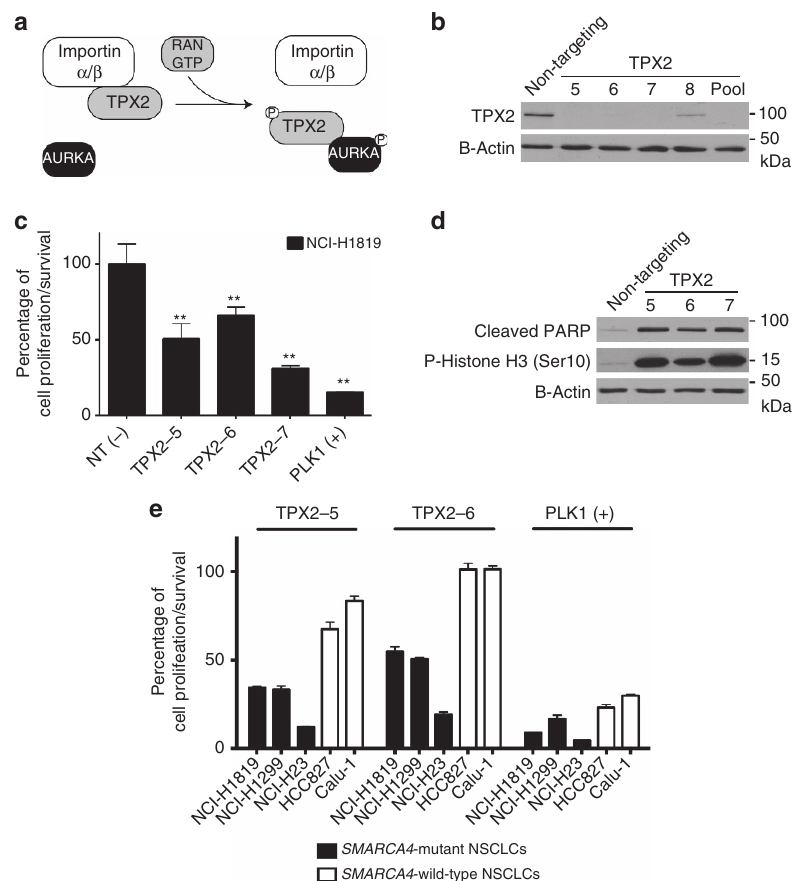
Figure 2 | Loss of TPX2 induces both apoptosis and mitotic arrest in NCI-H1819 cells. ( a ) Cartoon showing that TPX2 and RAN act sequentially to activate AURKA, a known regulator of mitosis. RAN prevents the inhibitory interaction of Importins on TPX2, allowing it to activate AURKA for mitotic spindle assembly. ( b ) Immunoblot analysis confirms that three of the four siRNAs greatly reduce TPX2 protein levels in NCI-H1819 cell lysates 3 days after transfecting the cells. ( c ) Five days after transfecting NCI-H1819 cells with non-targeting or individual siRNAs targeting TPX2, cell viability was measured with a CellTiter-Glo viability assay. PLK1 was depleted as the positive control. NT ¼ nontargeting. ** indicates statistical significance ( P o 0.001). Statistical significance was assessed by one-way ANOVA and post hoc Dunnett’s multiple comparison tests. ( d ) The effect of individual siRNAs on NCI-H1819 cells was measured by immunoblotting with monoclonal antibodies to cleaved poly (ADP-ribose) polymerase 1 (PARP), phospho-Histone H3 and b -Actin as a loading control 3 days after transfecting the cells with either non-targeting or TPX2-targeting siRNAs. Cleaved PARP indicated an active apoptotic response and phospho-Histone H3 indicated mitotic arrest. Data are representative of duplicate experiments. ( e ) Five days after transfecting NCI-H1819,